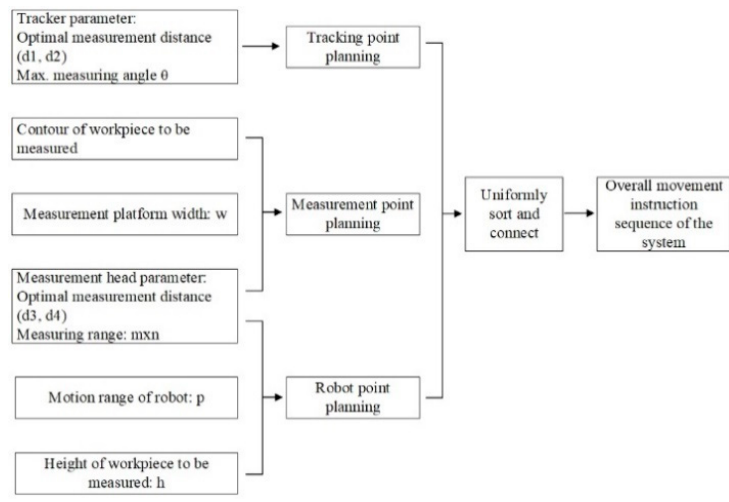
Figure 8. Trajectory planning parameter input process.